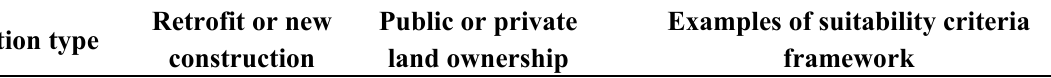
Table 7. Example of intervention types and possible suitability analysis